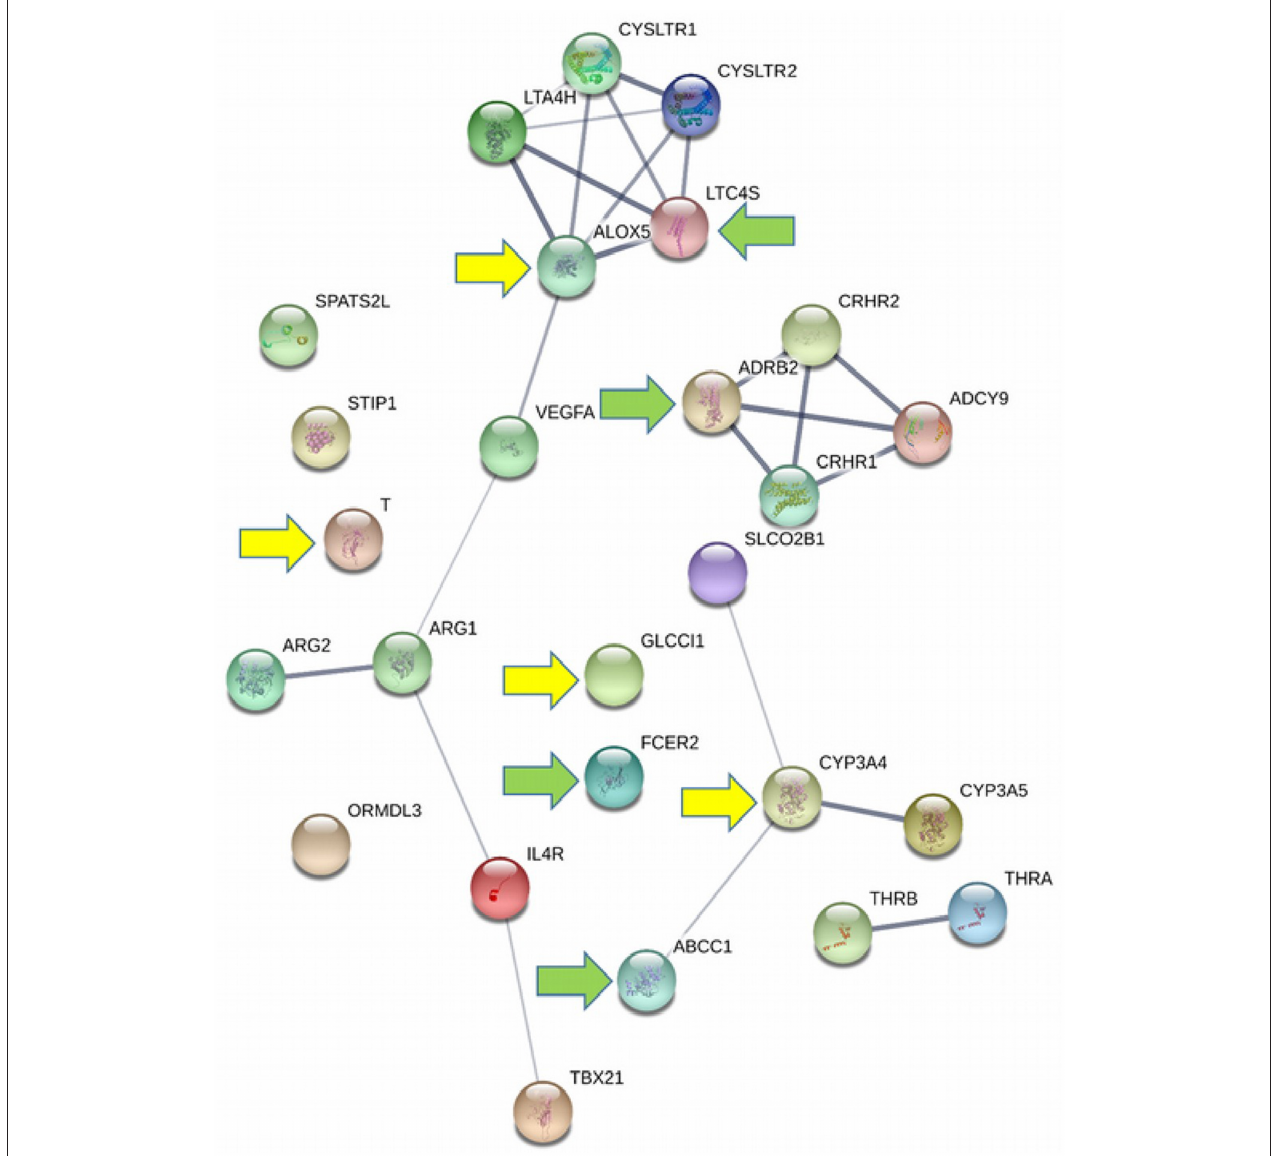
FIGURE 1 | Interactions between genes putatively related to the response to asthma therapy. The line thickness indicates the strength of data support. Green arrows indicate the most promising genes for pharmacogenomics implementation and yellow arrows indicate promising genes that require further